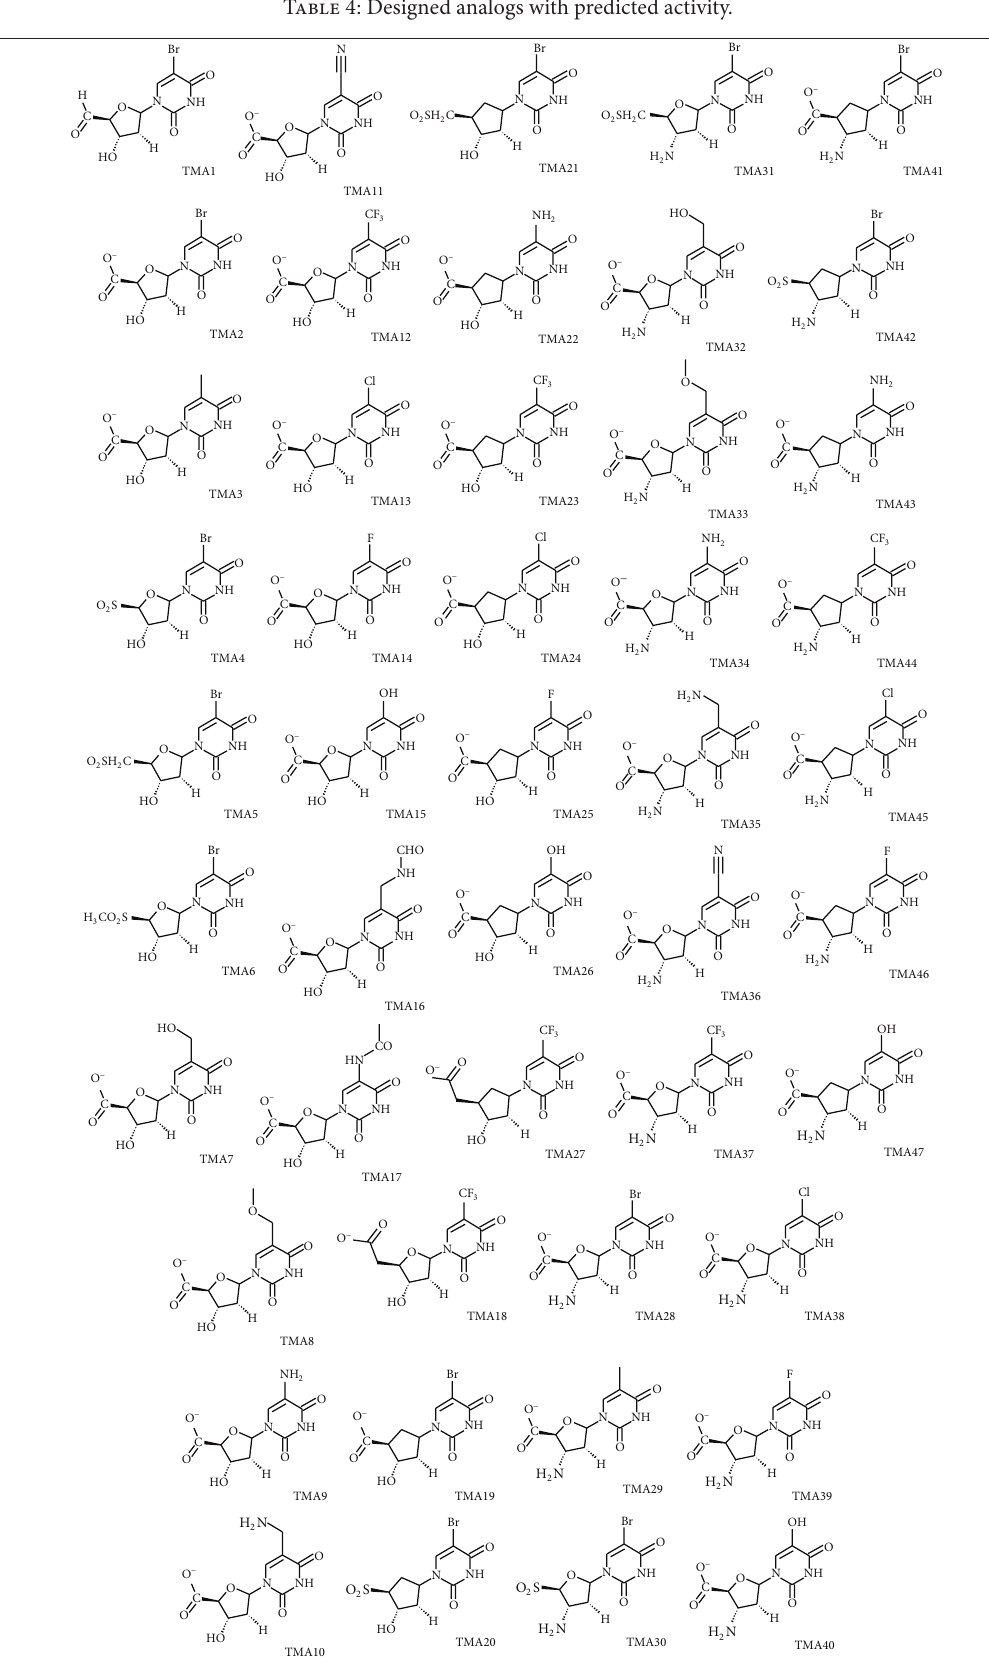
Table 4: Designed analogs with predicted